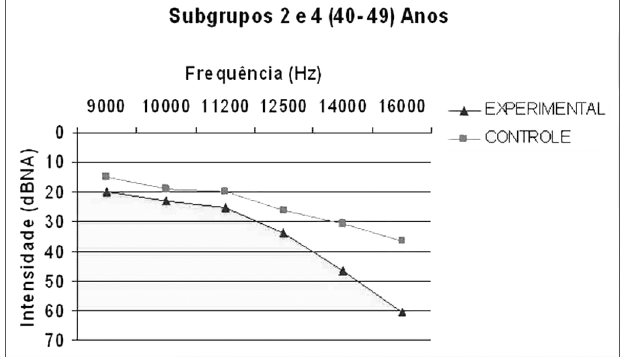
Gráfico 4. Médias da AAF na faixa etária de 40-49 anos dos grupos controle e de exposição ao ruído.